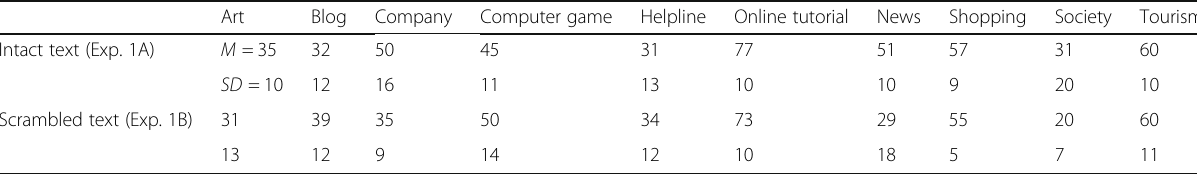
Table 2 Mean (in percent correct, top value in each cell) and standard deviation (in pp., bottom value in each cell) of performance in experiments 1A and 1B, computed across subjects ( N = 10 per experiment) per category. The mean values are identical to the diagonals of the confusion matrices in Figs. 3 and